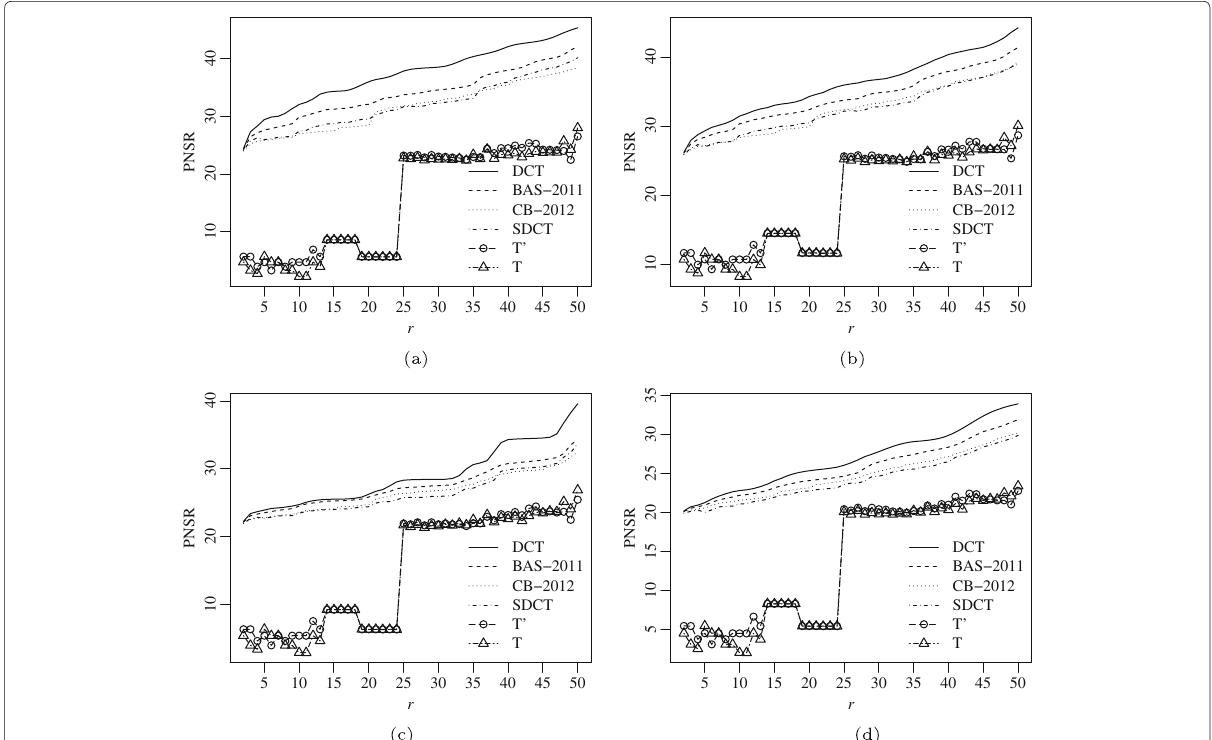
Fig. 5 PSNR measurements in terms of the number of retained coefficients r for selected standard images. a Lena, b Cameraman, c Barbara and d